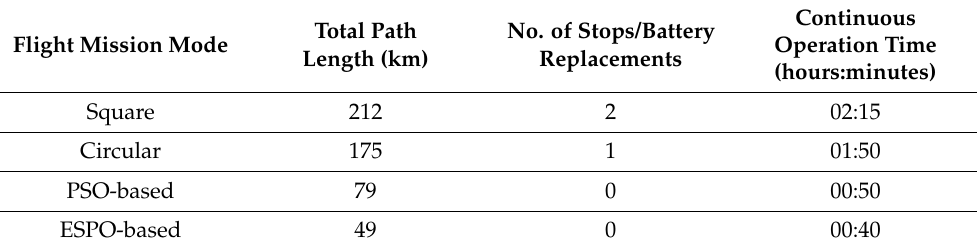
Table 6. Comparison of total traveling distance, operating hours, and the number of charging stops needed for different types of flight mission planning on the considered livestock farm. Total Flight Mission Mode